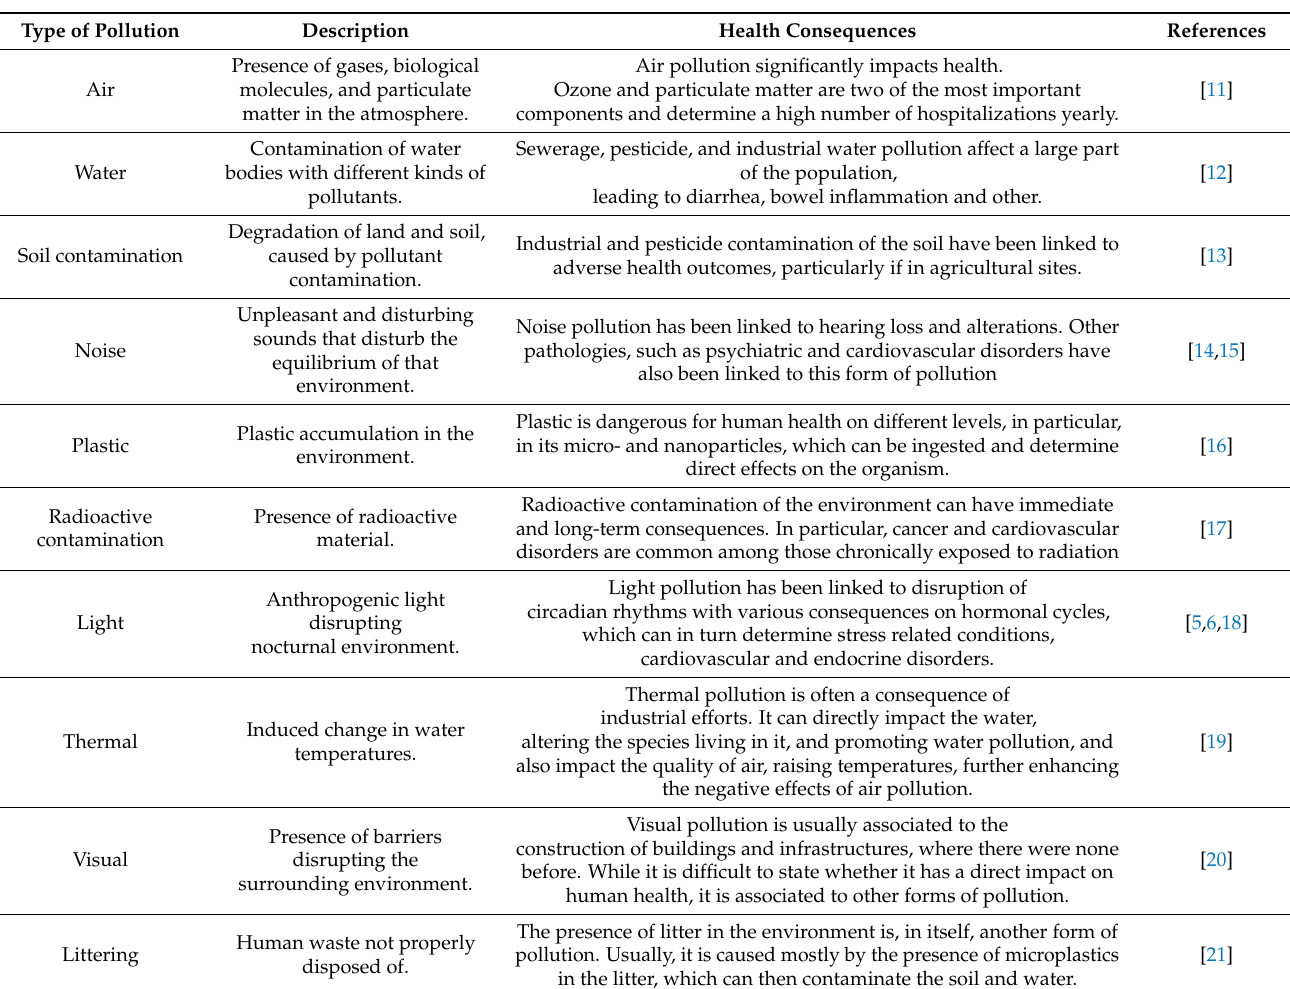
Table 1. Types of pollution and possible impact on human